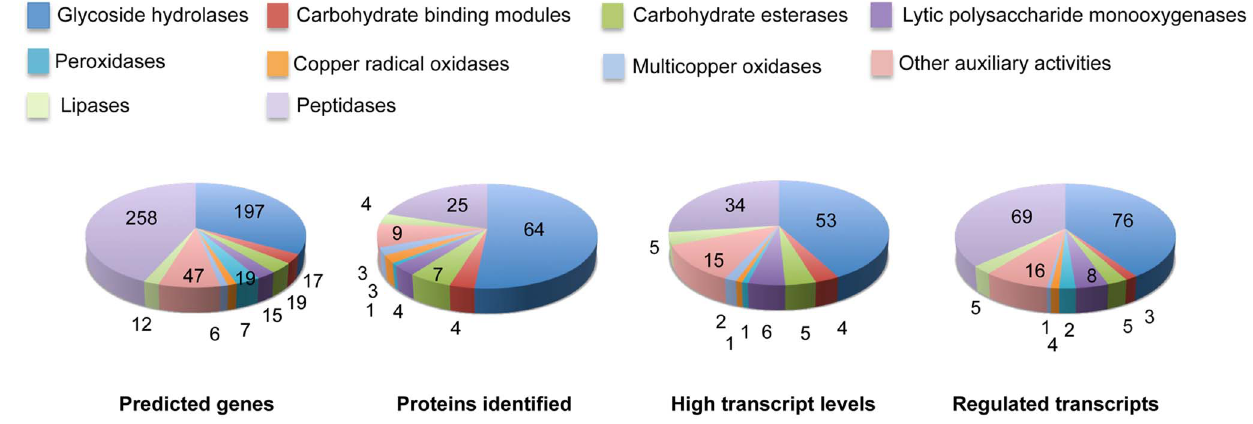
Figure 6. Number and expression of genes likely involved in lignocellulose degradation. The number of genes encoding mass spectrometry-identified proteins was limited to those matching $ 2 unique peptides after 5–9 days growth in media containing NELP or ELP. RPKM values . 100 for RNA derived from these cultures were arbitrarily selected as the threshold for high transcript levels. Genes designated as ‘regulated’ showed significant accumulation (p , 0.05; . 2-fold) in NELP or ELP relative to glucose containing media. Methods and complete data are presented in Text S1 and Dataset S2.